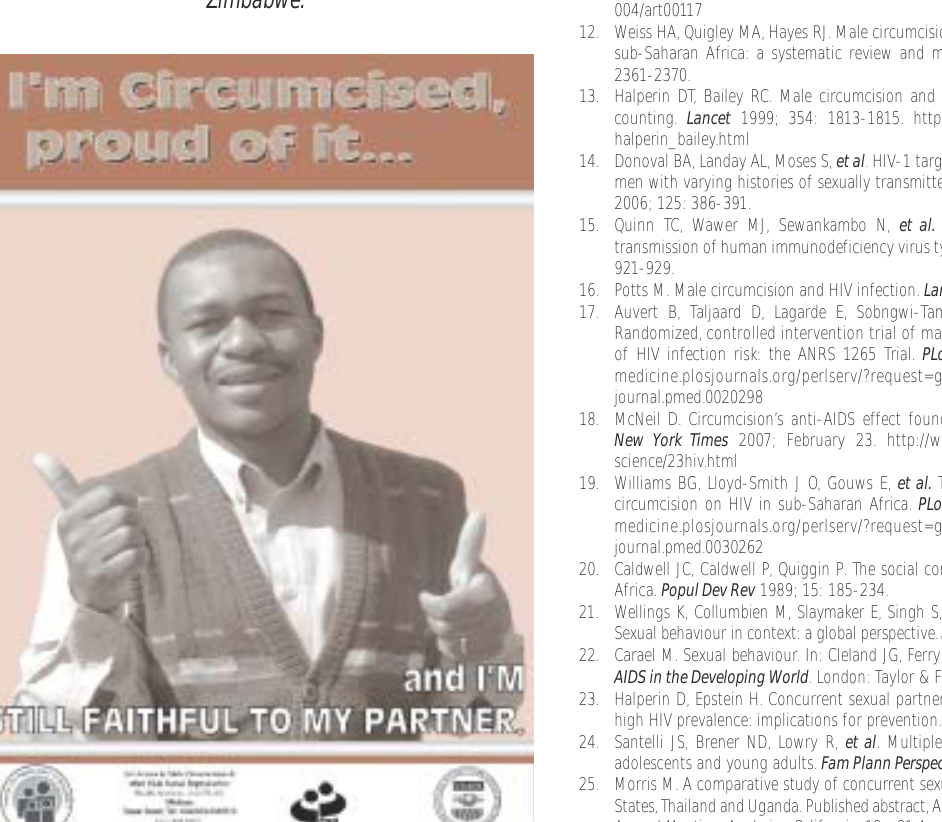
Fig. 7. Behaviour change among males in Manicaland,